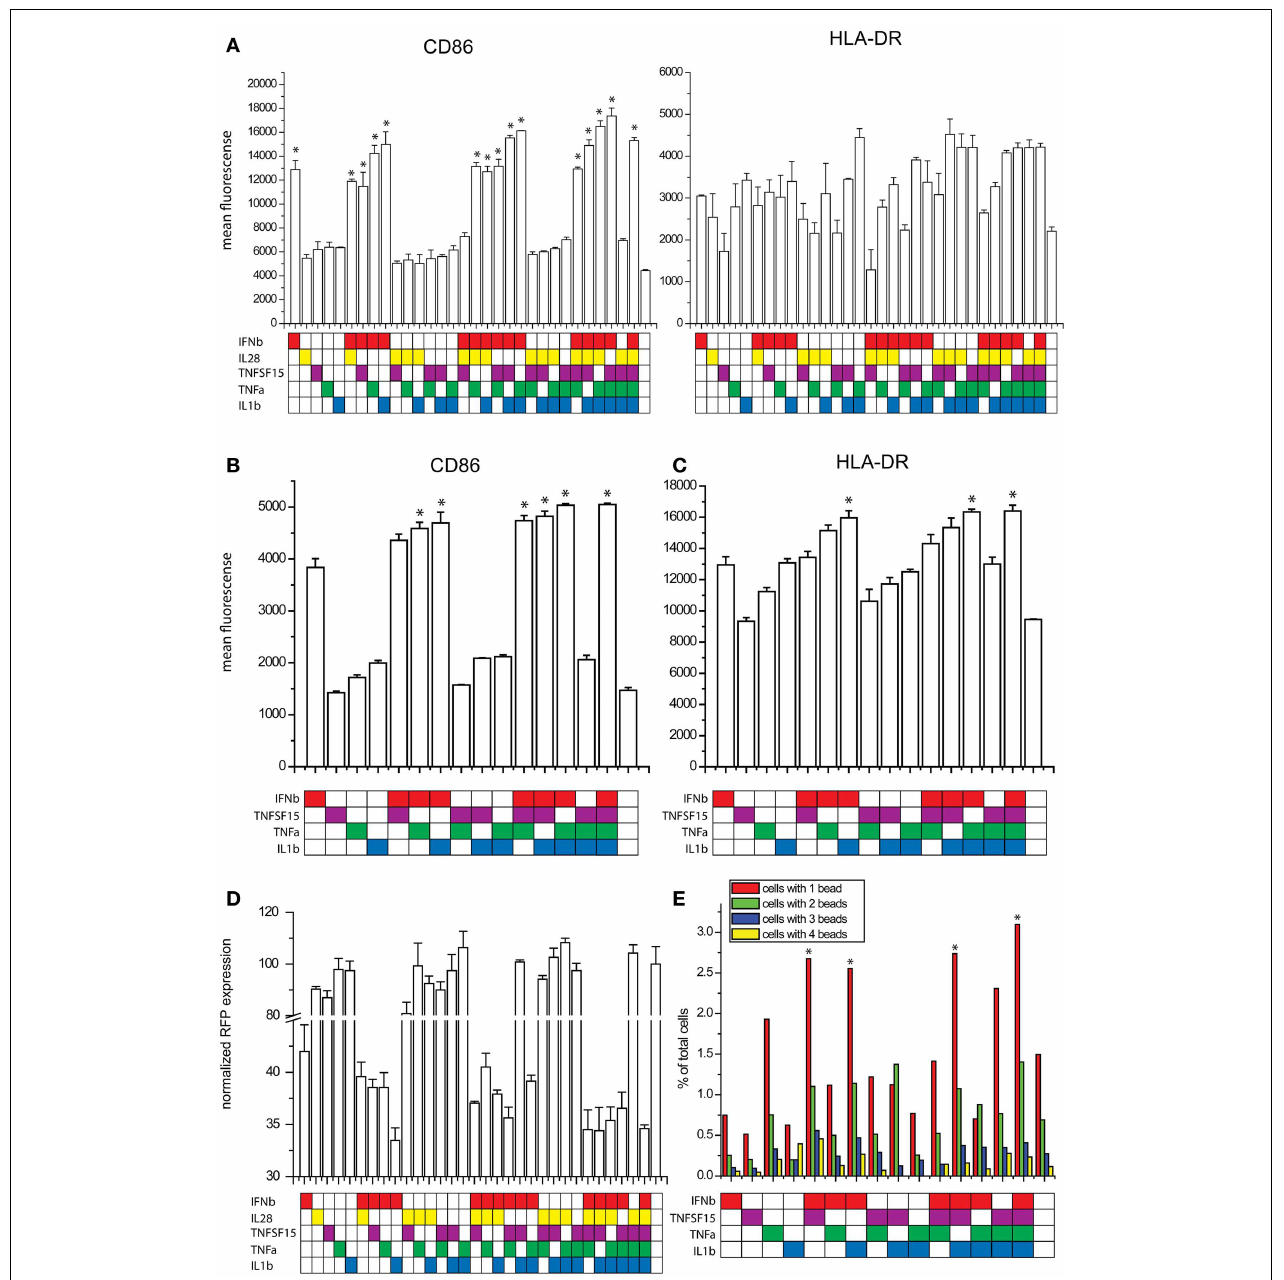
exposure to combinations of IFN β ,TNFSF15,TNF α and IL1 β , measured by flow cytometry (* p ≤ 0.05 compared to cells treated with IFN β alone). (D) Infectivity of NDV after cytokine combination pretreatment for 8h in DCs measured by RFP expression. (E) Phagocytosis assay measured by bead uptake by imaging flow cytometry (* p ≤ 0.05 compared to untreated cells). which showed a synergistic induction with CD86 (Figure S3 in Supplementary Material). These results support the view that the effects of combinatorial exposure produce a qualitatively different cellular effect than do the individual